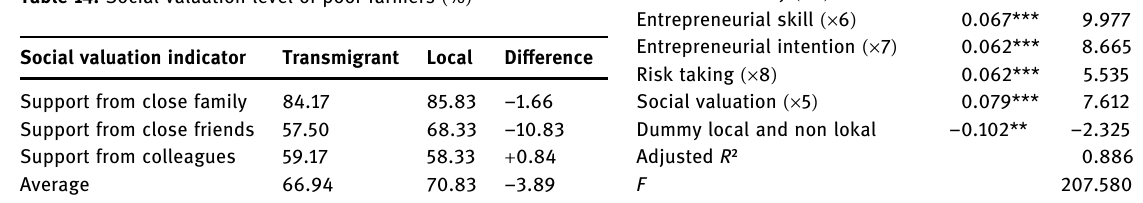
Table 14: Social valuation level of poor farmers ( % )